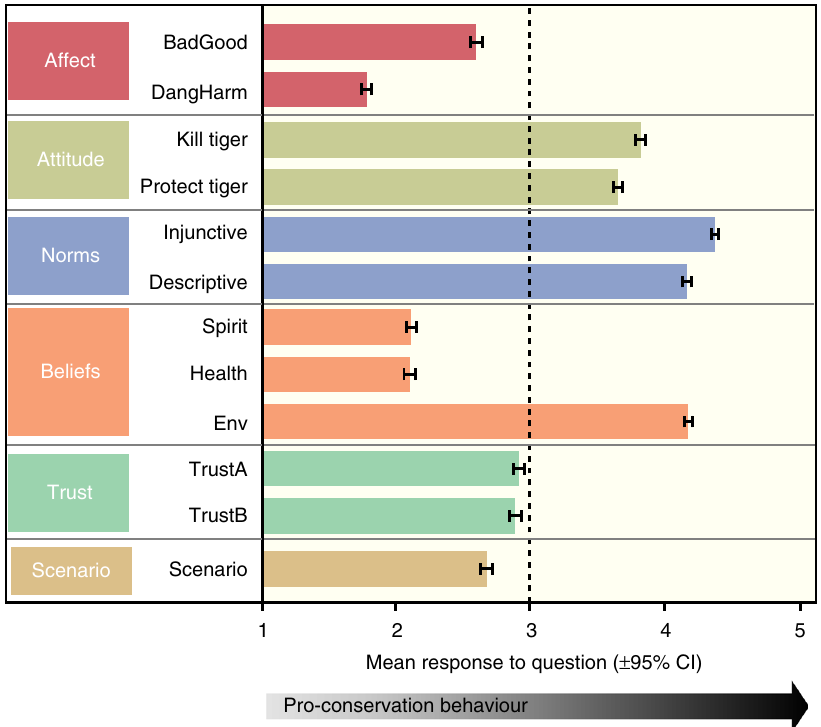
Fig. 2 Distribution of social variables reported by respondents in the tolerance questionnaire. Mean responses to questions on affect, attitude, norms, beliefs, trust and management scenarios concerned with tigers across 2386 villagers in Kerinci Seblat, Sumatra. Responses are rescaled from the original questions so that scores higher than three (neutral) indicate pro-conservation values. Error bars represent 95% con fi dence intervals from the